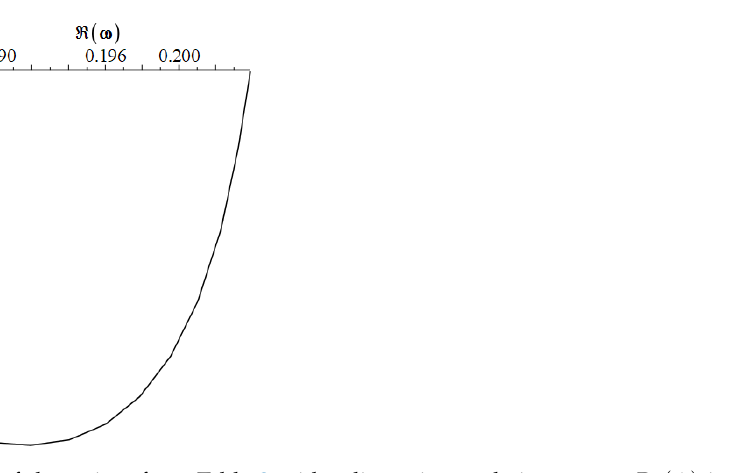
Figure 5. A plot of the points from Table 2 with a linear interpolation curve. Re ( ˆ ω ) increases monotonically with ˆ a , hence increasing ˆ a corresponds to one moving from left to